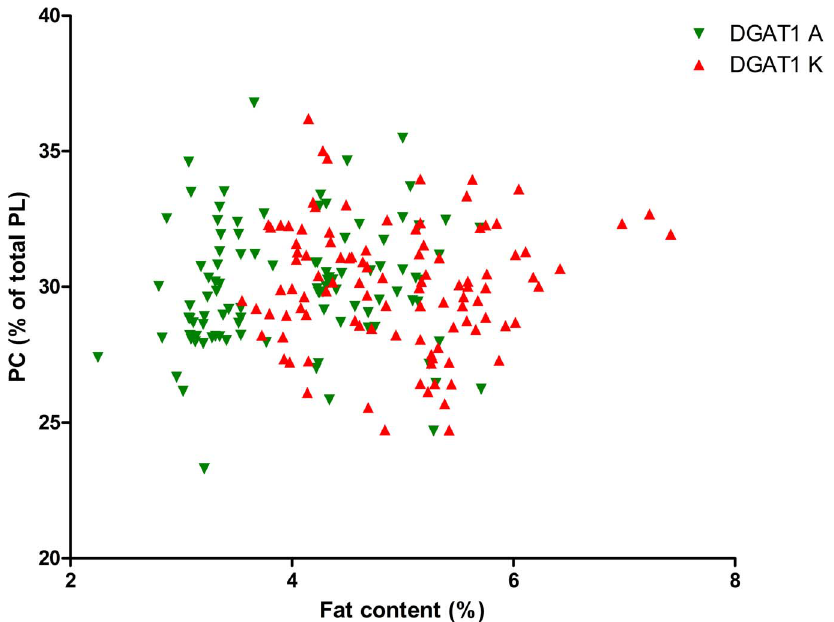
Figure 5. Relationship between fat content (%) and phosphatidylcholine (PC) content (% of total phospholipids (PL)) differentiated by DGAT1 genotype.